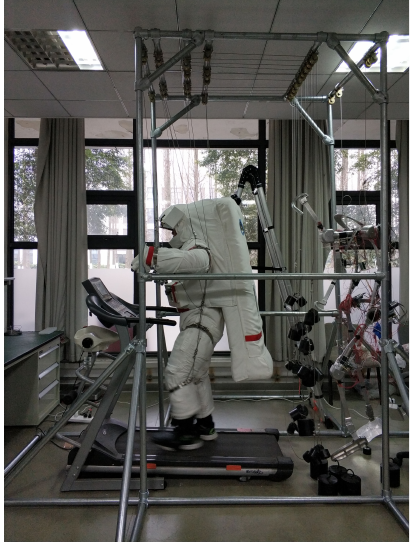
Figure 1. The suspended low-gravity experimental